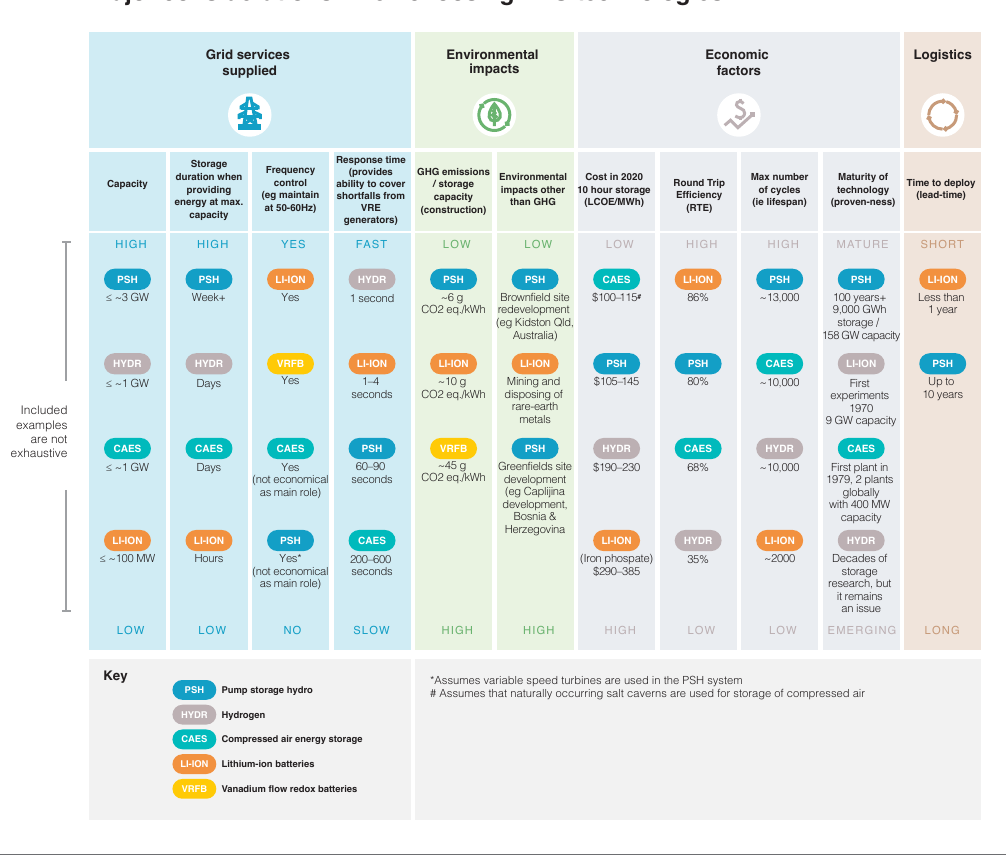
Figure 1. Major EES technology choice considerations (Source: authors, data from